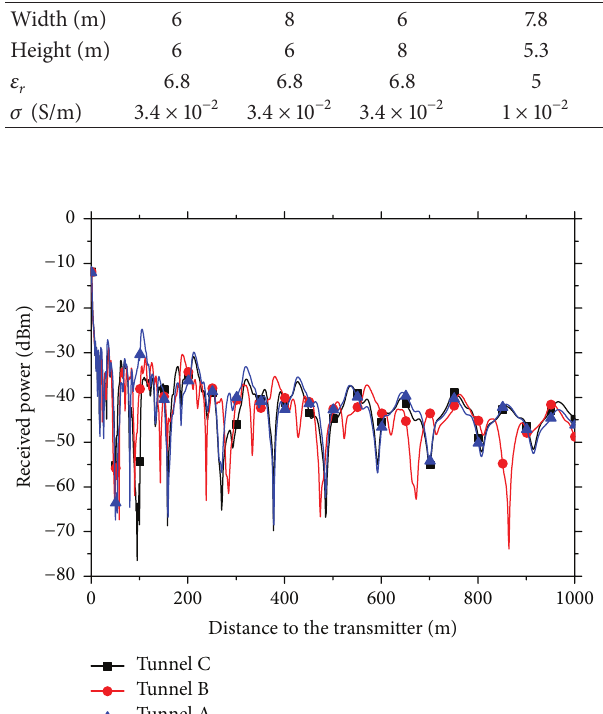
Figure 3: Comparison of the received power curves tested in differ- ent tunnels with the proposed modal method.